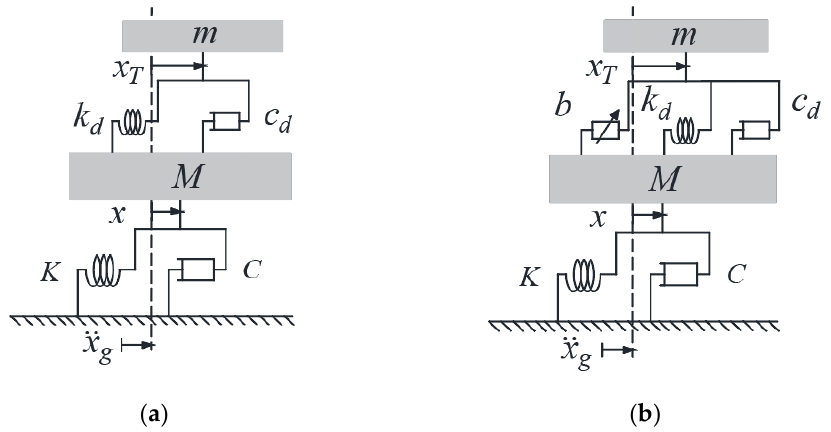
Figure 5. Model of the SDOF structure incorporated with: (a) passive TMD (b) considered adap- tive TMID.